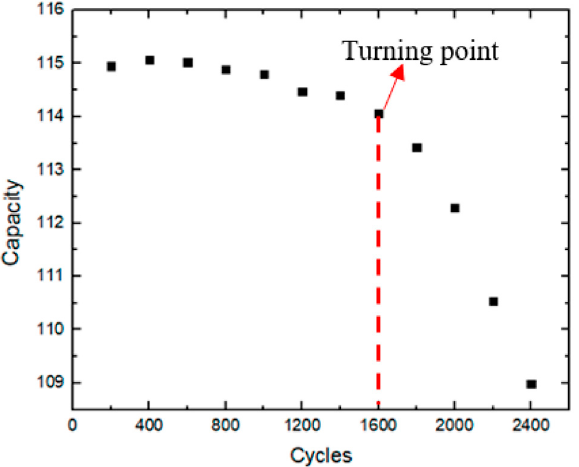
Figure 8. Capacity decline curve of a battery of the same